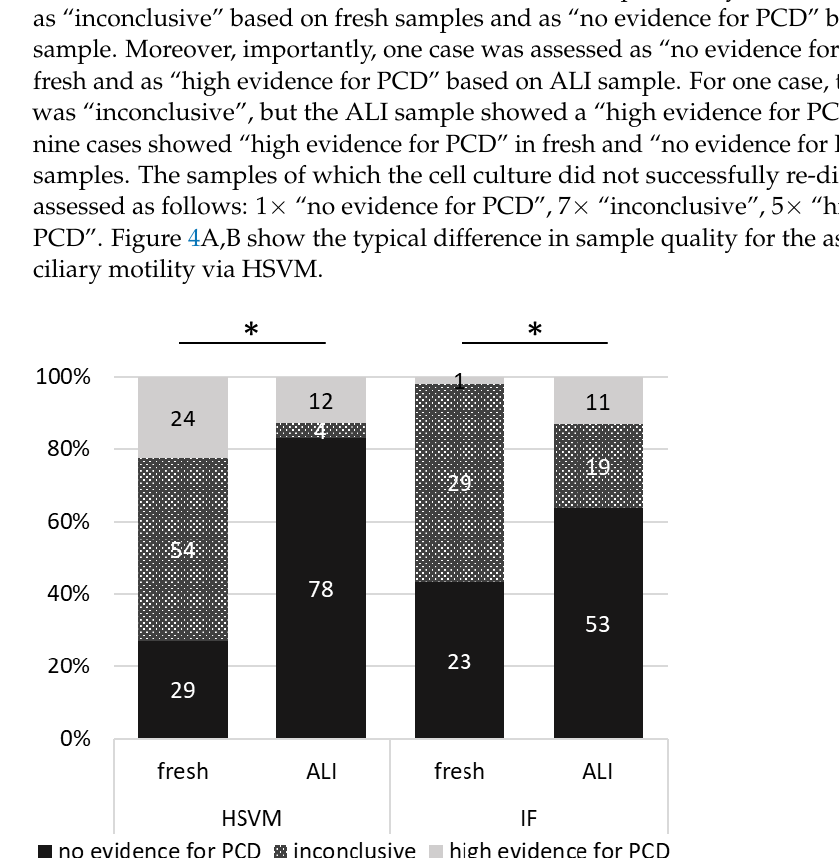
Figure 3. Differences in the assessments of ciliary motility via HSVM and presence of structural ciliary proteins via IF stainings in fresh and ALI samples. For HSVM fresh, we analyzed 107 samples in total, as re-brushings were performed for seven patients. Two of the samples could not be analyzed at all since no viable cells were found. We had a usable cell culture for 94 patients. For five patients we had no ALI and for one patient, the cell culture was not stable and lost all cilia before reaching maturity (at 28 days), and could not be analyzed. * Statistically significant difference between HSVM fresh versus ALI for “no evidence for PCD” ( p < 0.0001), “inconclusive” ( p < 0.0001) and “high evidence for PCD” ( p = 0.04) and IF fresh versus ALI for “inconclusive” ( p = 0.03). Differences between IF fresh versus ALI were not significant for “no evidence for PCD” ( p = 0.18) and “high evidence for PCD” ( p = 0.38). Data were compared using the Wilcoxon matched-pairs signed rank test (GraphPad Prism Version